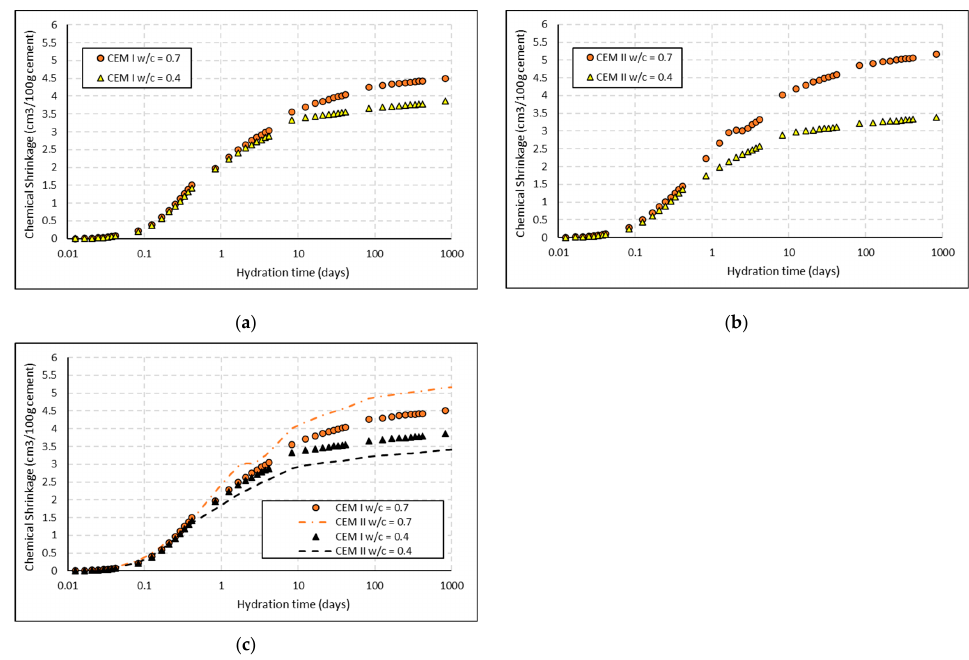
Figure 3. Predicted chemical shrinkage over time for the ( a ) CEM I and ( b ) CEM II/A-L cements and ( c ) a comparison of both.